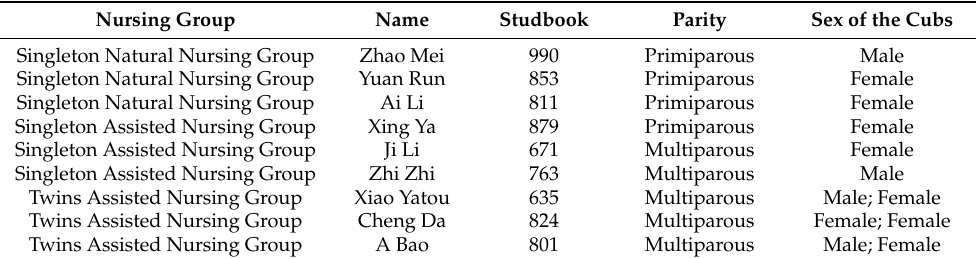
Table 1. Experimental group from Chengdu Research Base of Giant Panda Breeding (CHENPANDA) (Chengdu,